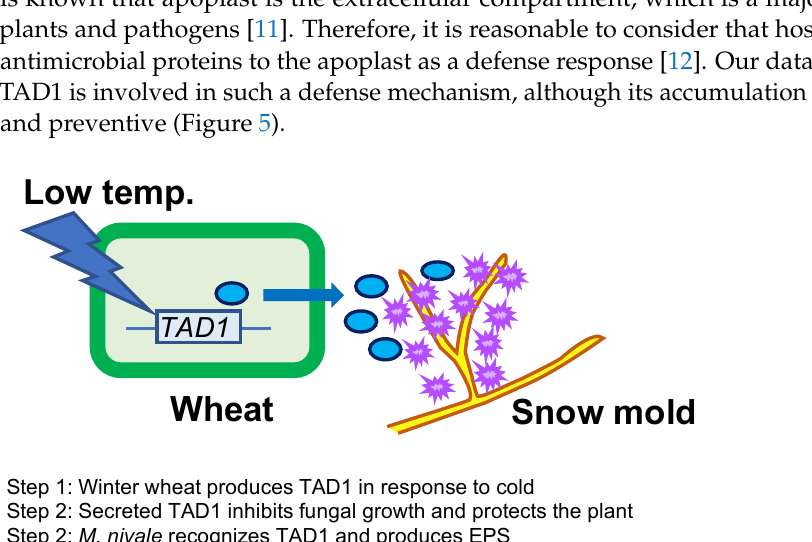
Figure 4. TAD1 accumulated to a high level within the EPS layer. Microscopic observation of M. nivale mycelia after incubating spores at 15 °C for 7 days with FITC-labelled rmTAD1 (10 µg/mL) through bright field and FITC filter sets. The first row ( A , B ) represents the images without cellulase. The second row ( C , D ) represents the images with cellulase.